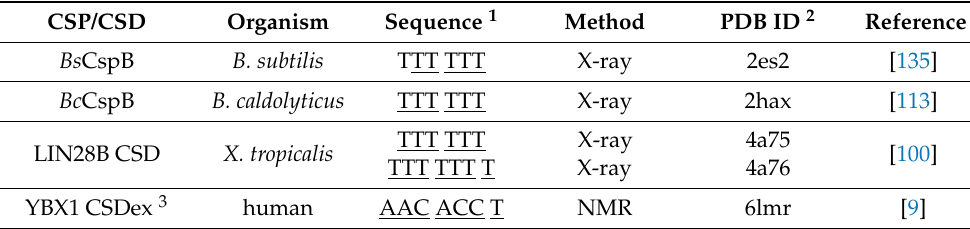
Table 1. Structures of CSP/CSD: DNA complexes.